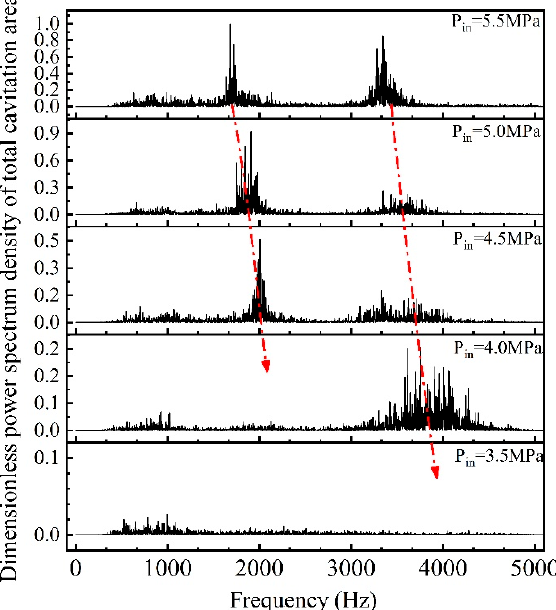
Figure 8. Power spectral density of cavitation area under different inlet pressures.